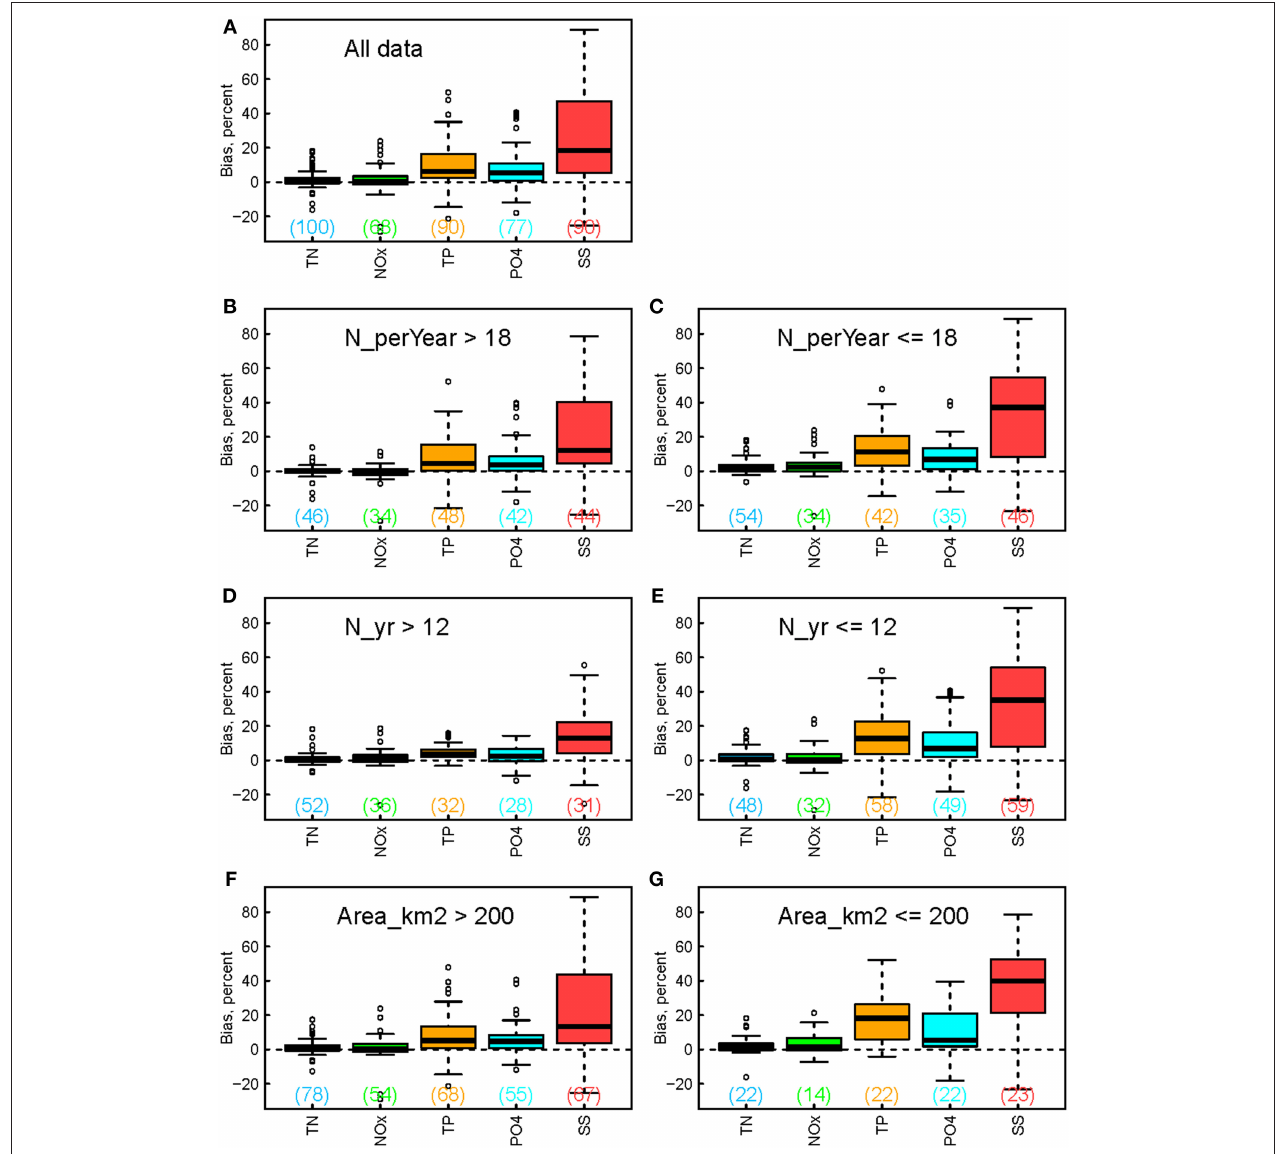
FIGURE 2 | Boxplots showing the estimation bias for constituent flux for (A) all data and (B-G) their subsets. The subsets correspond to different groups of (B,C) sampling frequency, (D,E) sampling record length, and (F,G) watershed size. Numbers in the brackets indicate numbers of applicable sites for each